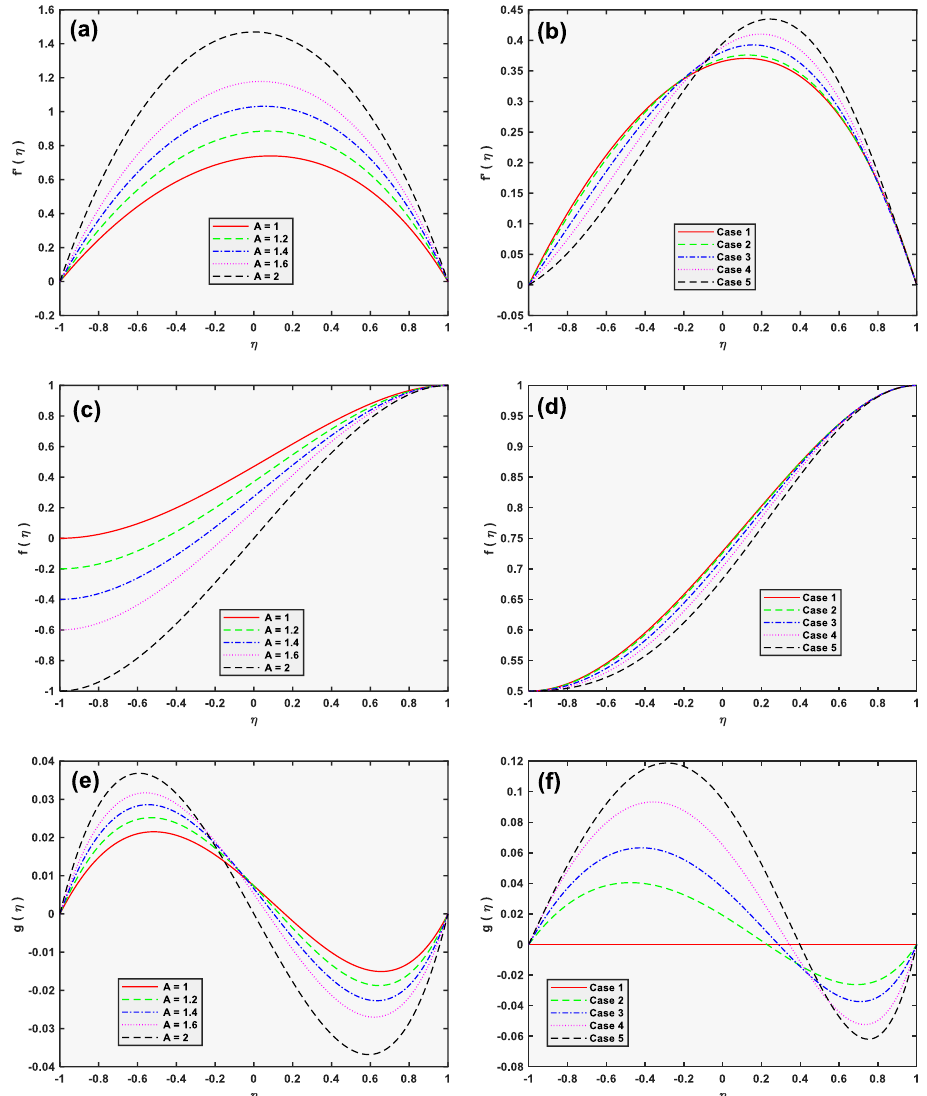
Figure 4. Impact of the permeability parameter A and the micropolar parameters C 1 , C 2 , C 3 on different profiles ( a ) Streamwise velocity with different A ; ( b ) Streamwise velocity with various cases; ( c ) Normal velocity with different A ; ( d ) Normal velocity with various cases; ( e ) Microrotation with different A ; ( f ) Microrotation with various